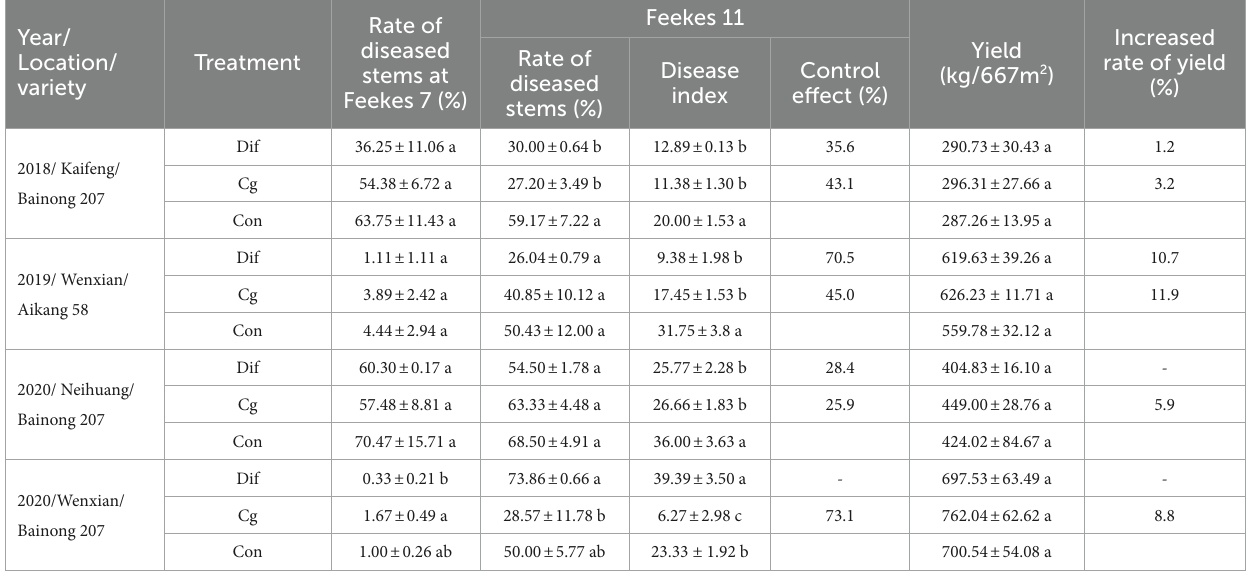
TABLE 1 Field control effect of seed coating with Chaetomium globosum 12XP1-2-3 on wheat FCR and its effect on yield in Kaifeng, Wenxian and Neihuang Counties of Henan from 2018 to 2020.